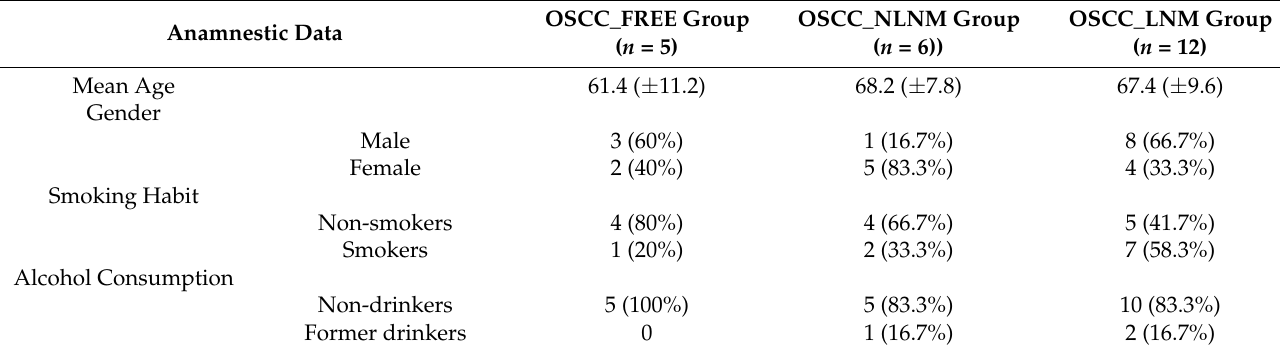
Figure 1. ( A ) Saliva samples used in the study. ( B ) Flowchart of S/SEV purification protocol. Table 1. Demographic and clinical/anamnestic data of the enrolled patients.